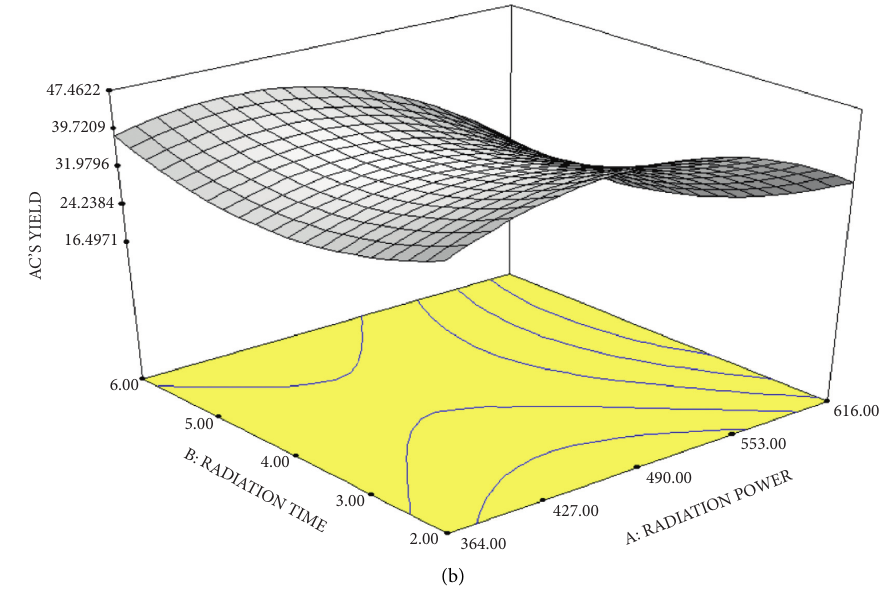
Figure 8: 3D response surface plots for (a) DDT removal and (b) CSAC’s